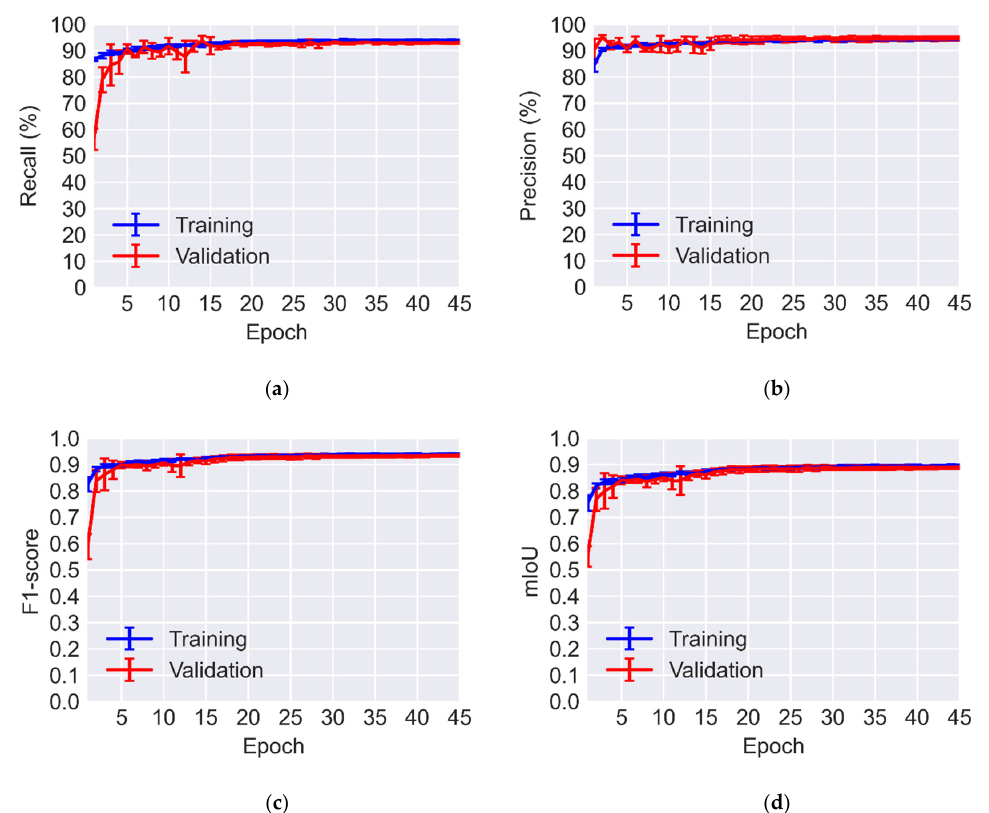
Figure 7. Accuracy metrics versus epochs for 5-fold cross-validation: ( a ) Recall; ( b ) Precision; ( c ) F1- score; ( d ) mIoU.